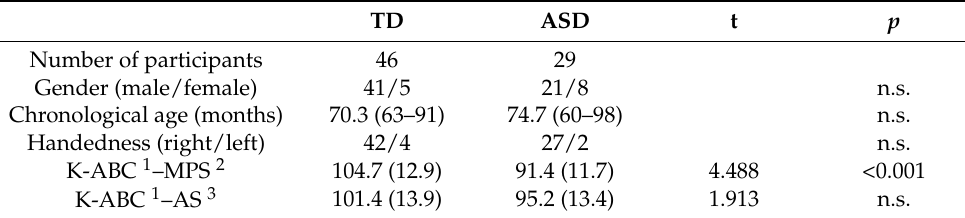
Table 3. Clinical